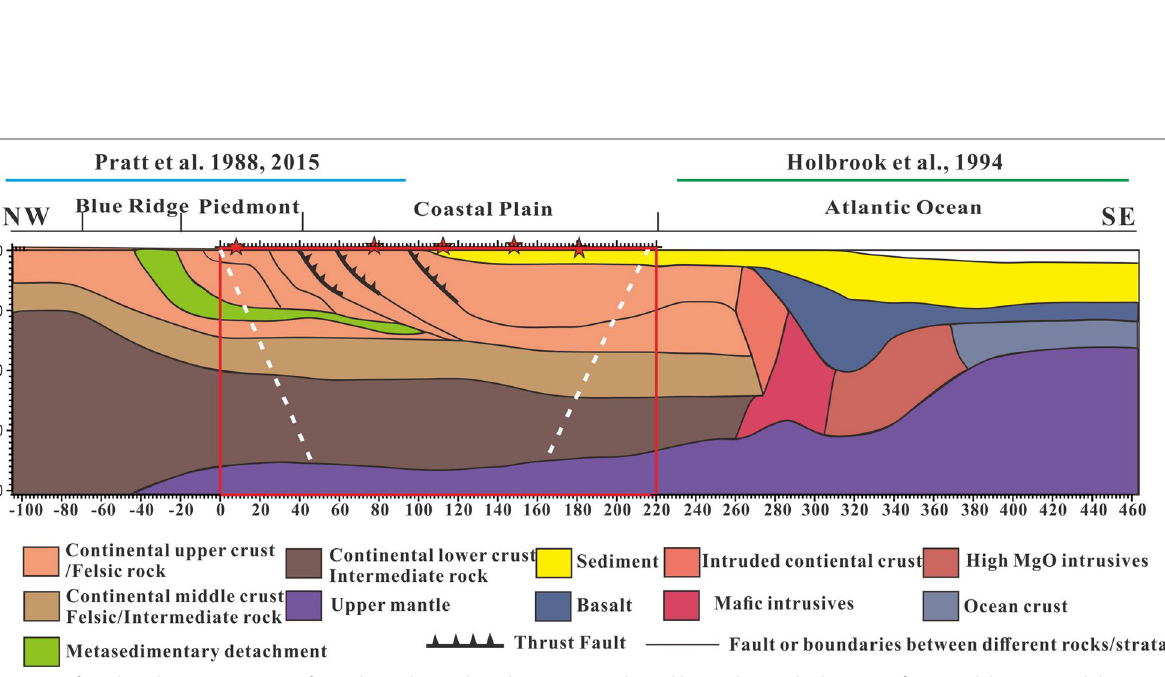
Fig. 15 Inferred geologic cross section from Blue Ridge to the Atlantic Ocean. The red box indicates the location of our model (Fig. 8), and the dash white lines show the range of the seismic rays used for the velocity inversion. Combining our study with the studies of Pratt et al. (1988, 2014), Holbrook et al. 1994 (Fig. 14b), and the surface geology (King and Beikman 1974; Glover and Klitgord 1995), we infer the geometry of the faults and crustal boundaries. The profiles of Pratt et al. (1988, 2014) and Holbrook et al. (1994) are located about 70 km north of our Line 1 profile, and we have migrated the model for Line 1 along the geological boundaries in Fig. 1 to create a composite section. Offshore crustal petrologic interpretations are from Holbrook et al.